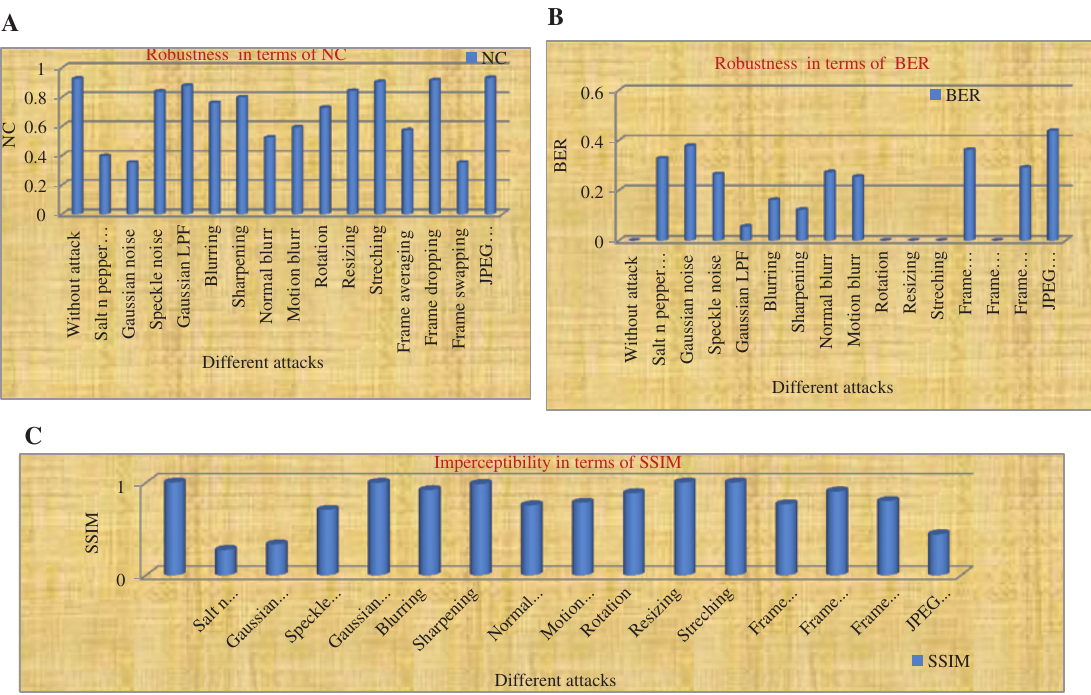
Figure 8: Analysis of Different Attacks in Watermarking Using the LL Subband (Algorithm 2). (A) Robustness in Terms of NC; (B) Robustness in Terms of BER; (C) Imperceptibility Analysis in Terms of Similarity Index After Different Attacks.